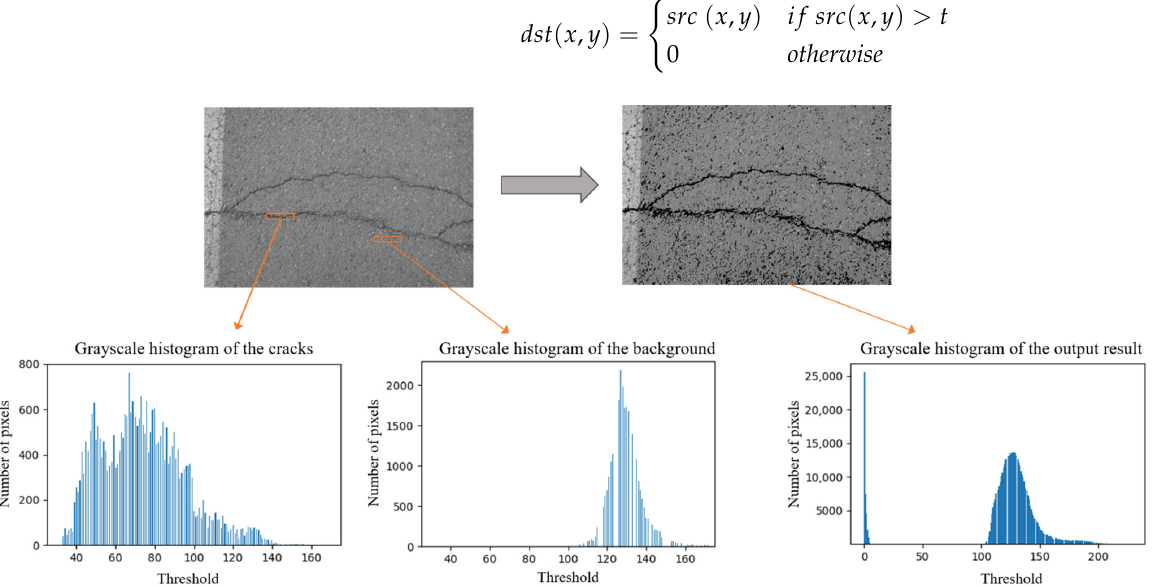
Figure 5. Schematic diagram of the 4th algorithm.